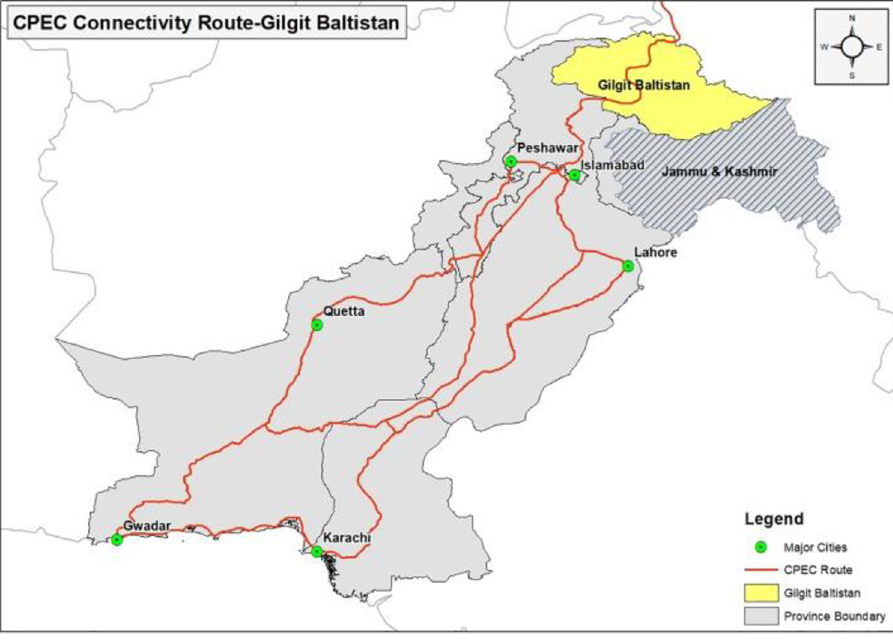
Fig 1. CPEC map silk road route in Pakistan from China. source: